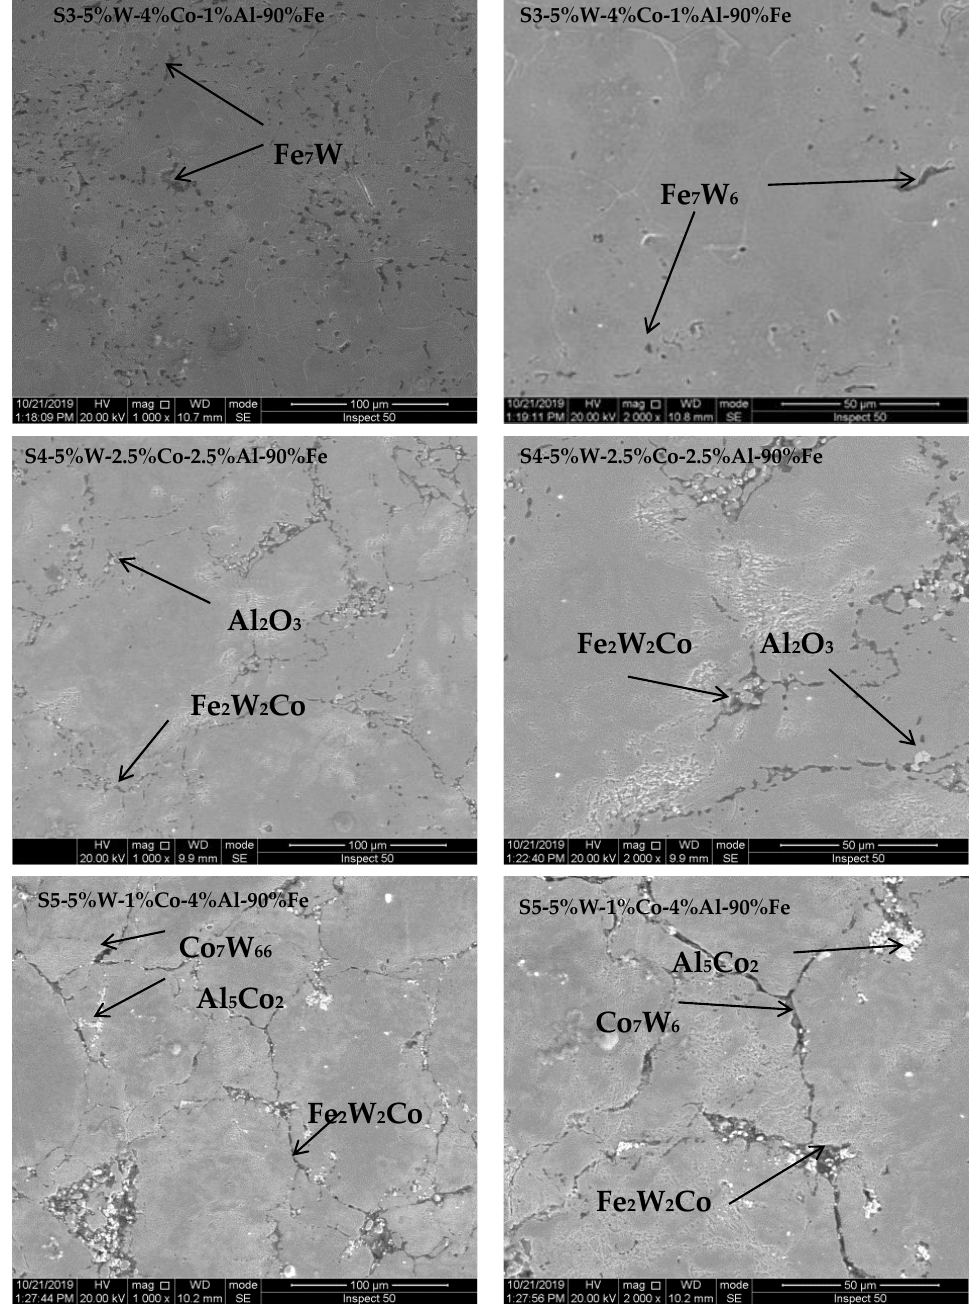
Figure 5. Microstructures of samples 3, 4, and 5 at two different magnifications. The area fraction of pores in 5%W added sample was higher than that of the pure iron sintered sample, which implies that W in solid solution increased the porosity. This